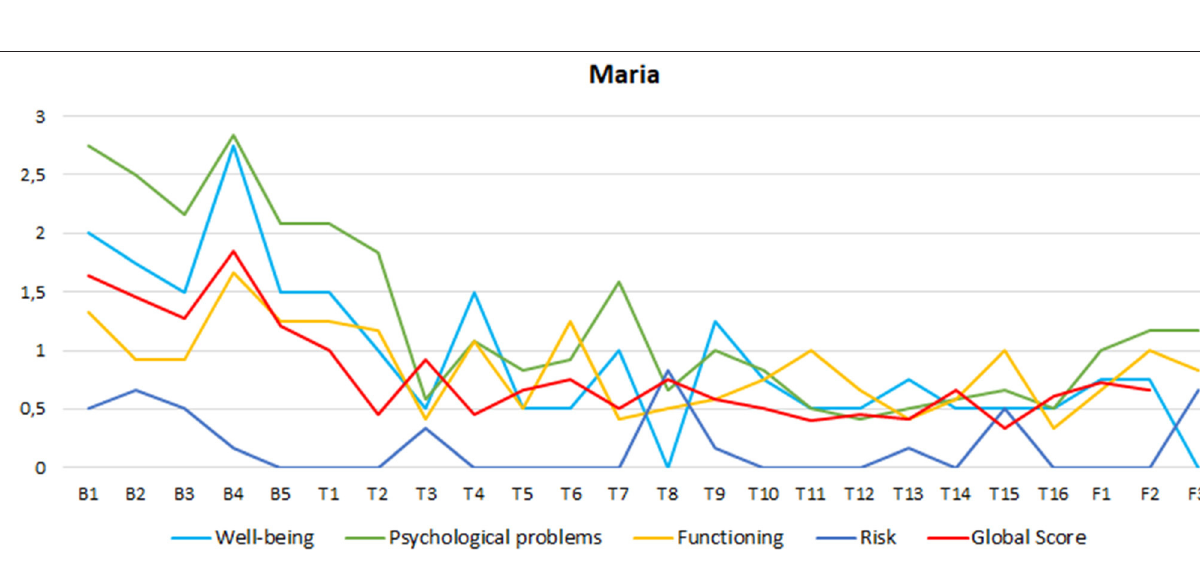
FIGURE 2 | Maria’s CORE-OM subscales scores in Baseline, (B) Treatment (T) and Follow-up (F)